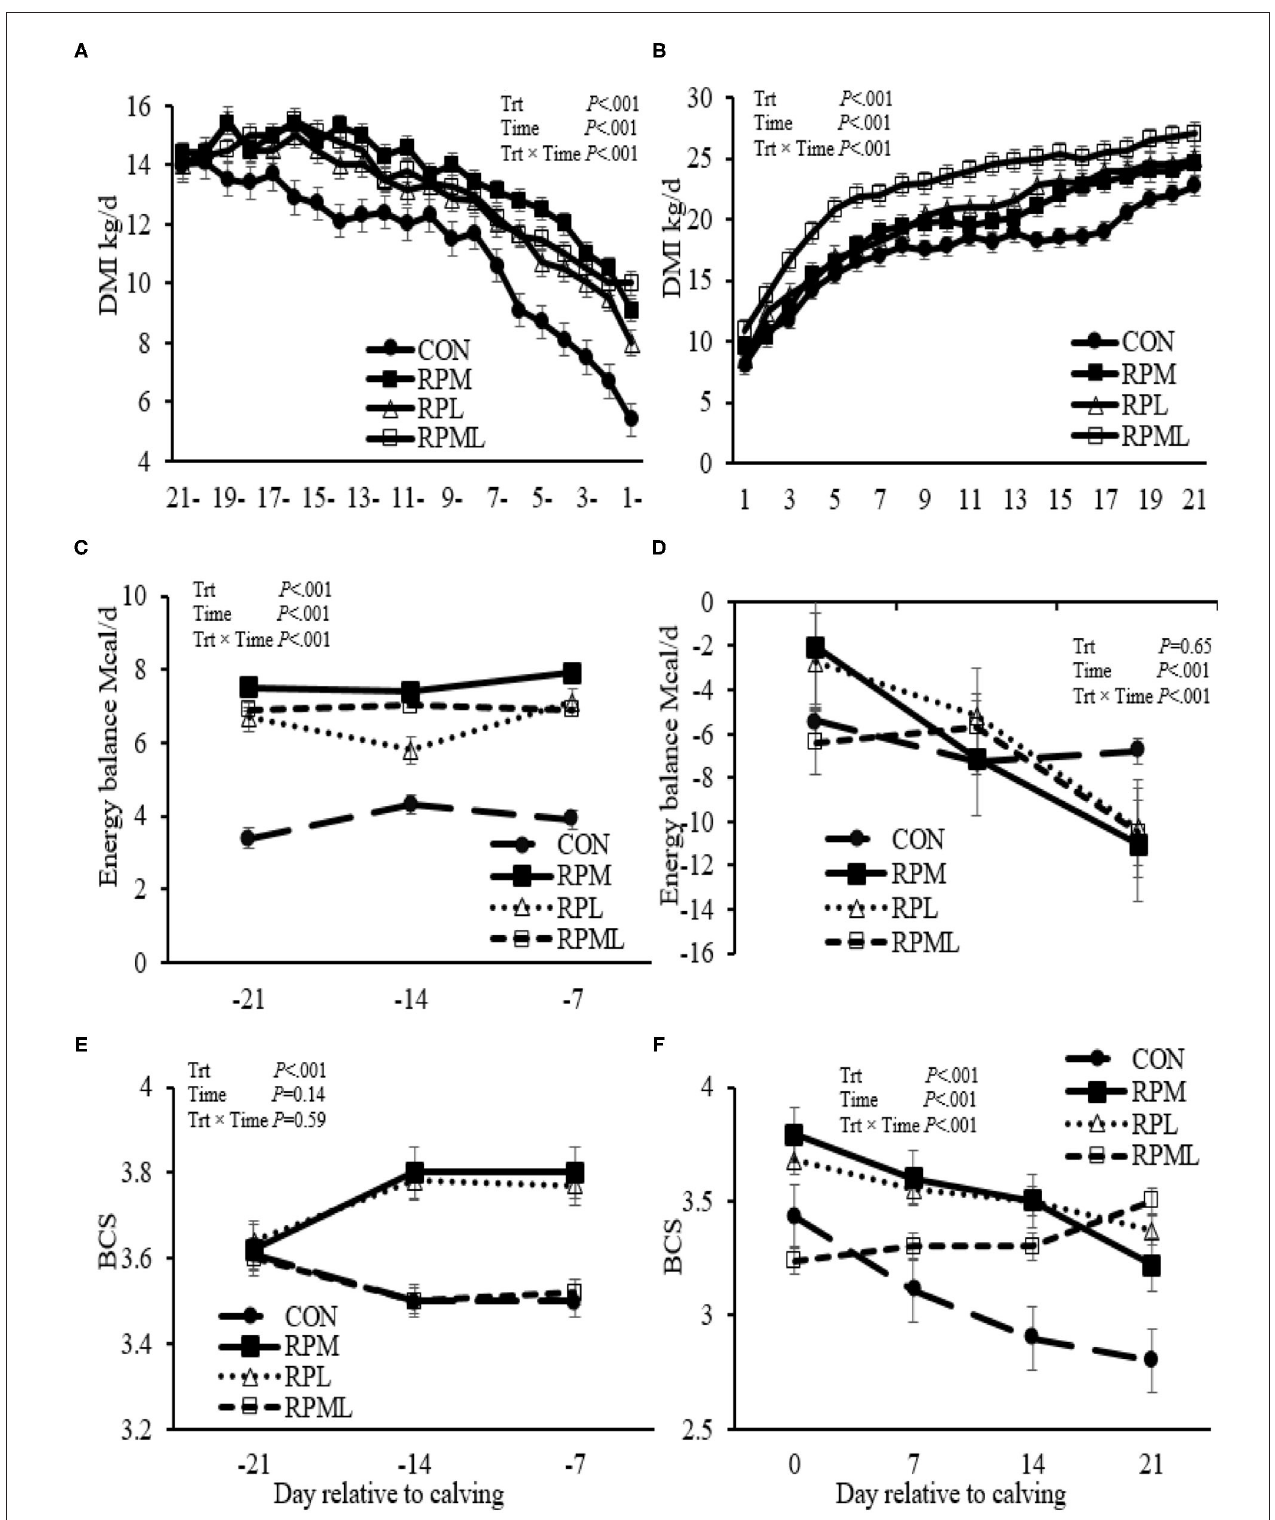
FIGURE 1 | Effect of ruminally protected Lys and Met supplementation on dry matter intake, energy balance (EB; Mcal/d), and body condition score of Holstein dairy cows during the transition period. Values are means; standard errors are represented by vertical bars.